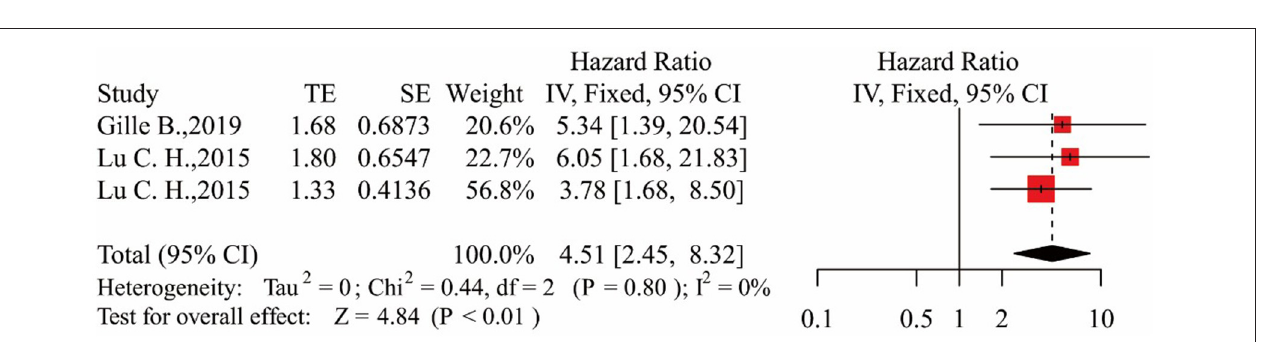
FIGURE 3 | Forest map showing the relationship between NfL levels and survival (middle NfL group relative to low NfL group).